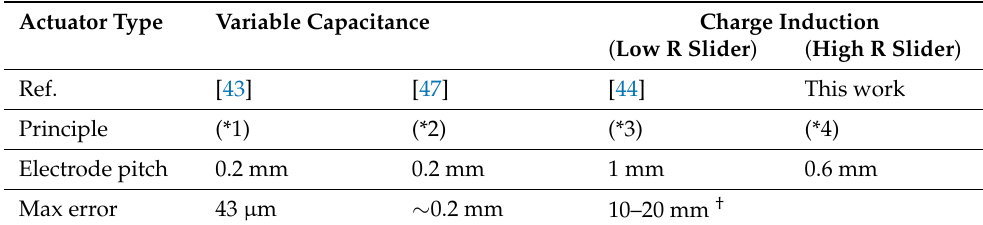
Table 1. Built-in sensing methods for electrostatic film actuators. Actuator